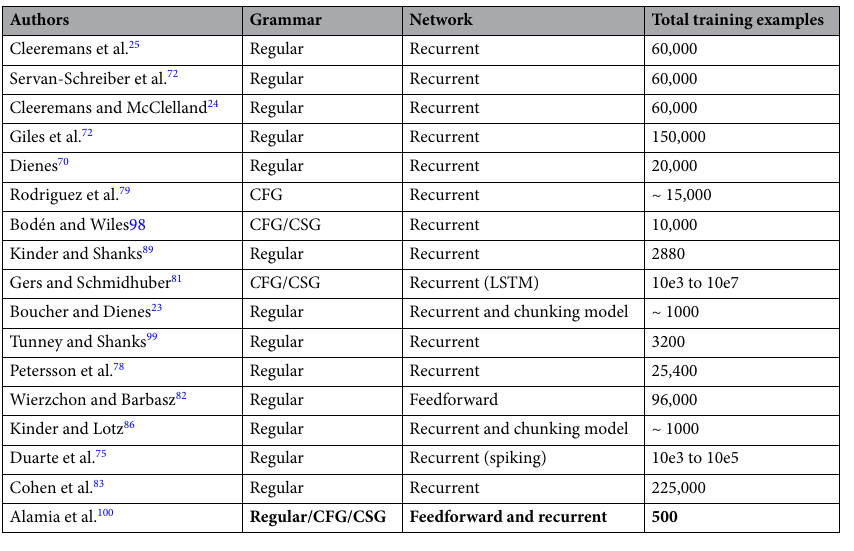
Table 1. Representative overview of studies training artificial neural networks to classify novel strings. Most studies employed recurrent networks over regular grammars. The last column provides the total number of sequences the network was trained on (sequences per epoch, times the number of epochs). Our study, highlighted in bold, employs the smallest number of training examples, a few orders of magnitude smaller than most studies, and similar to typical experimental studies in